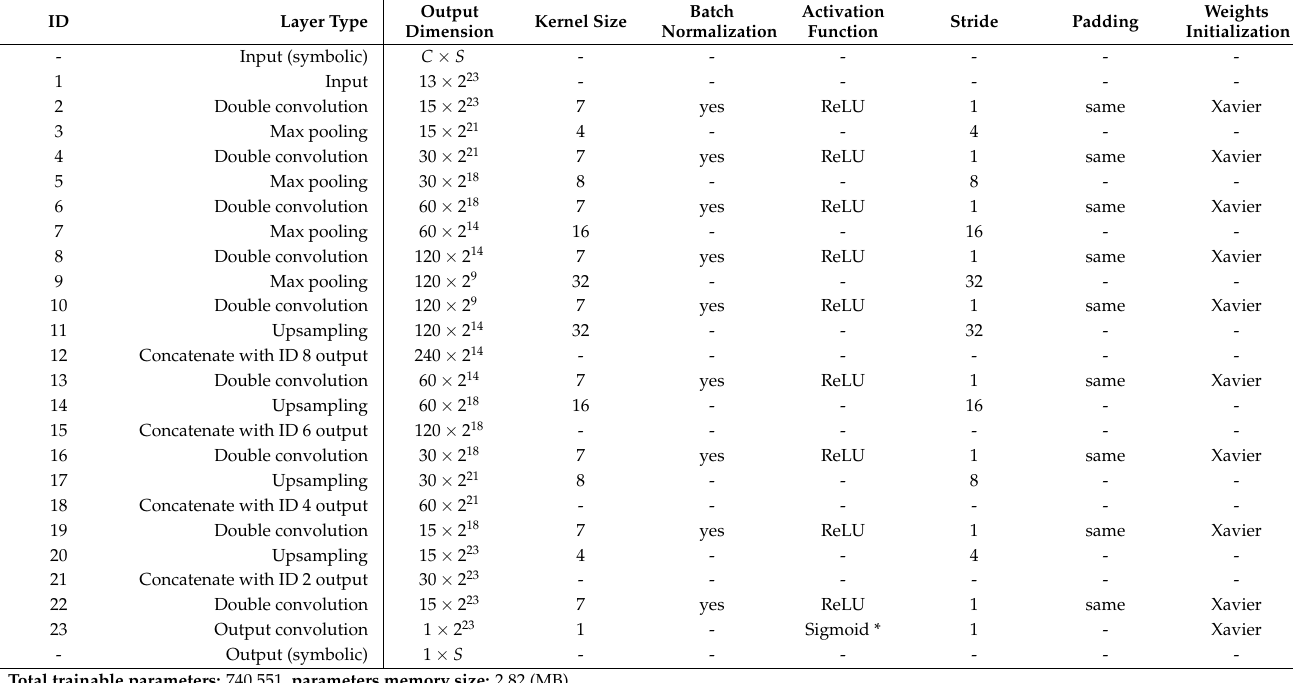
Table 1. DeepSleep 2.0 model architecture with C = 13 physiological channels and input